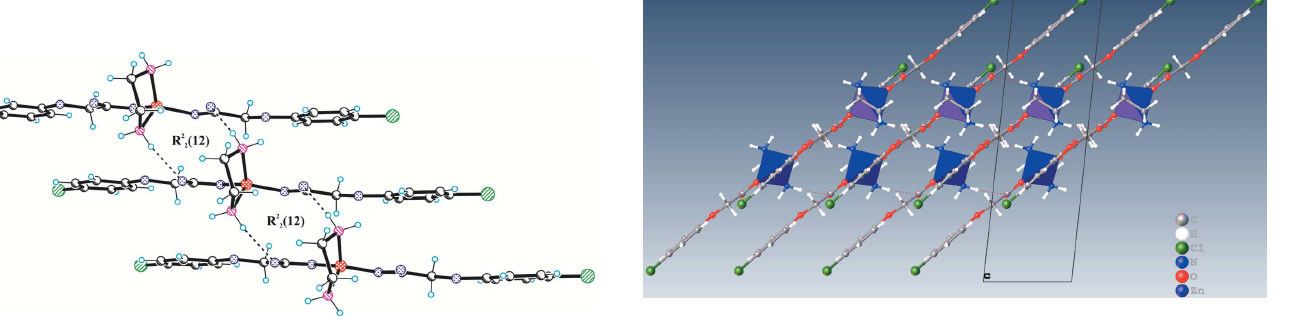
Figure 3 The packing of the molecules in the title complex in a view along [010]. Intermolecular hydrogen bonding is shown as dashed red lines.